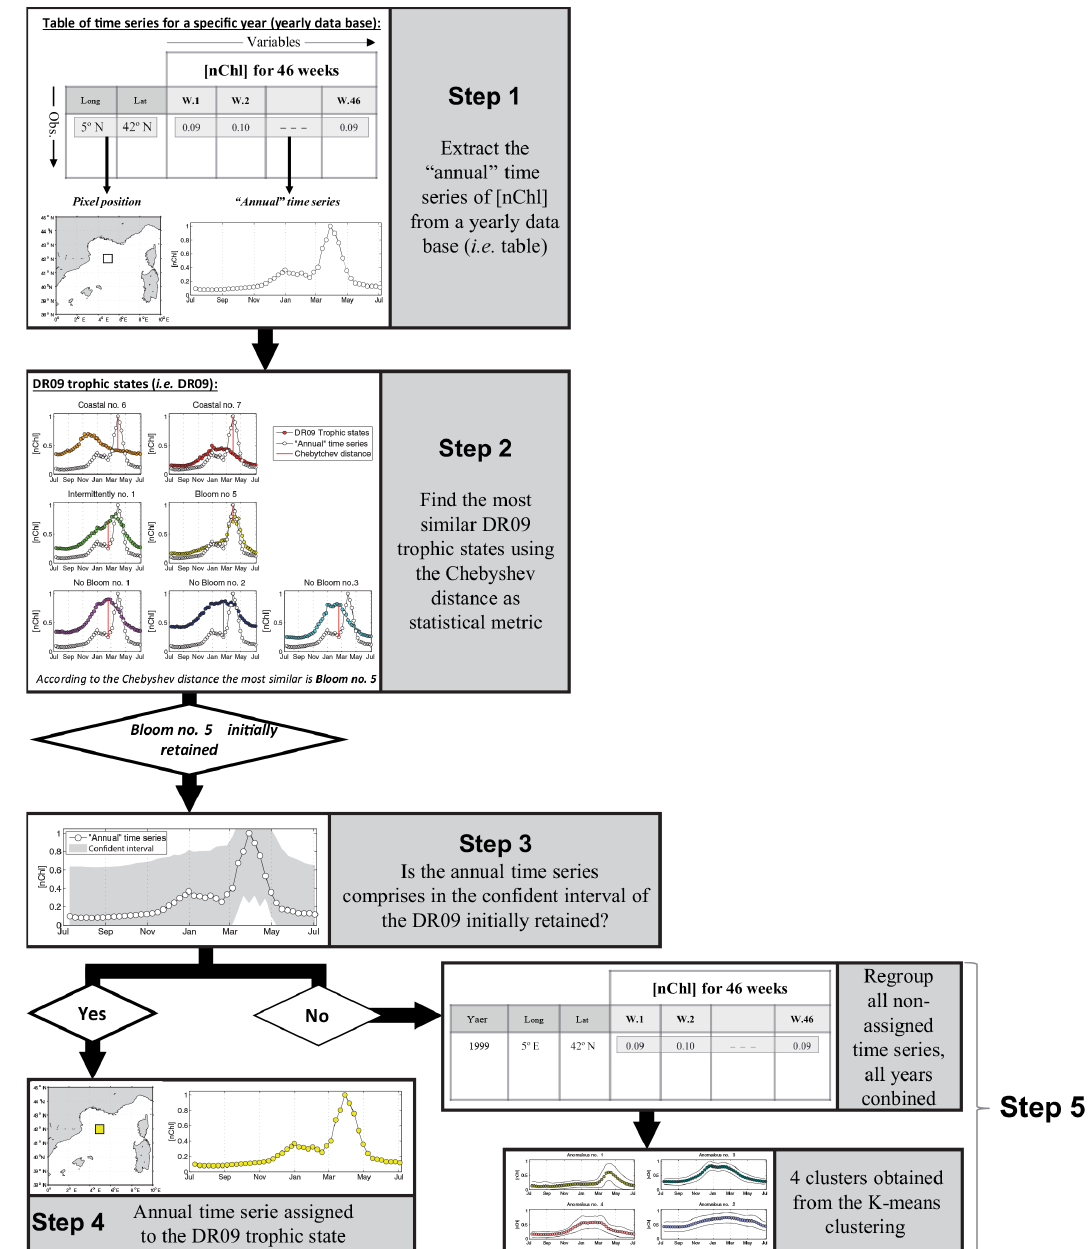
Figure 1. Schematic representation of the different steps of the method used in this study (see Sect. 2.2 for